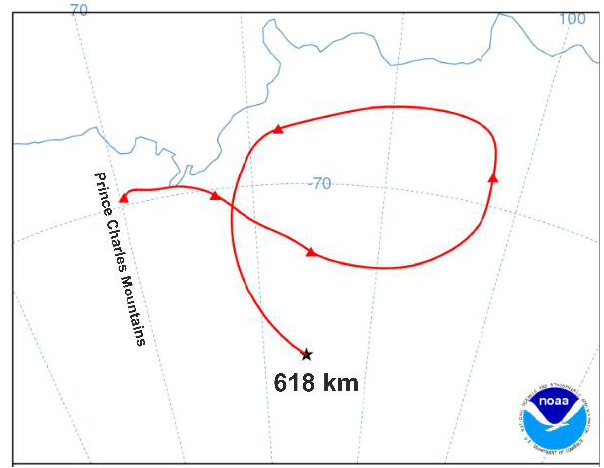
Fig. 5. Example of the 5-day back trajectory to the 5000m level over the 618km site (25 February